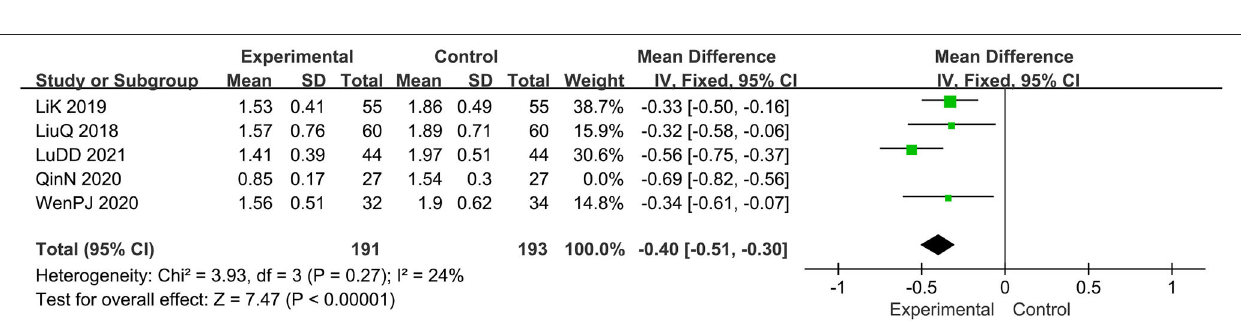
FIGURE 5 | The meta-analysis for the score of lesions (without the heterogeneity